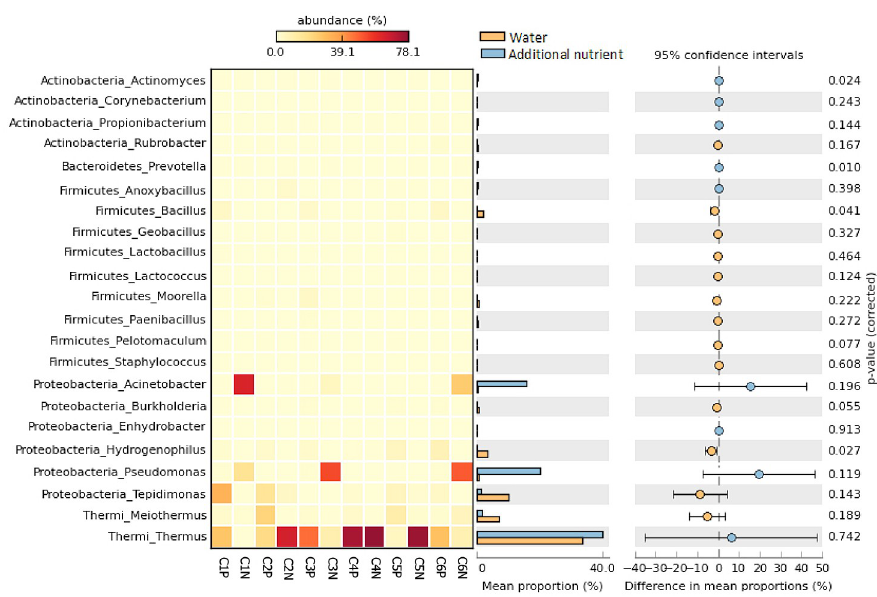
Fig 4. Comparative analysis of genus abundance in bacterial communities from the controls (C1P-C6P) and nutrient-treated samples (C1N-C6N).